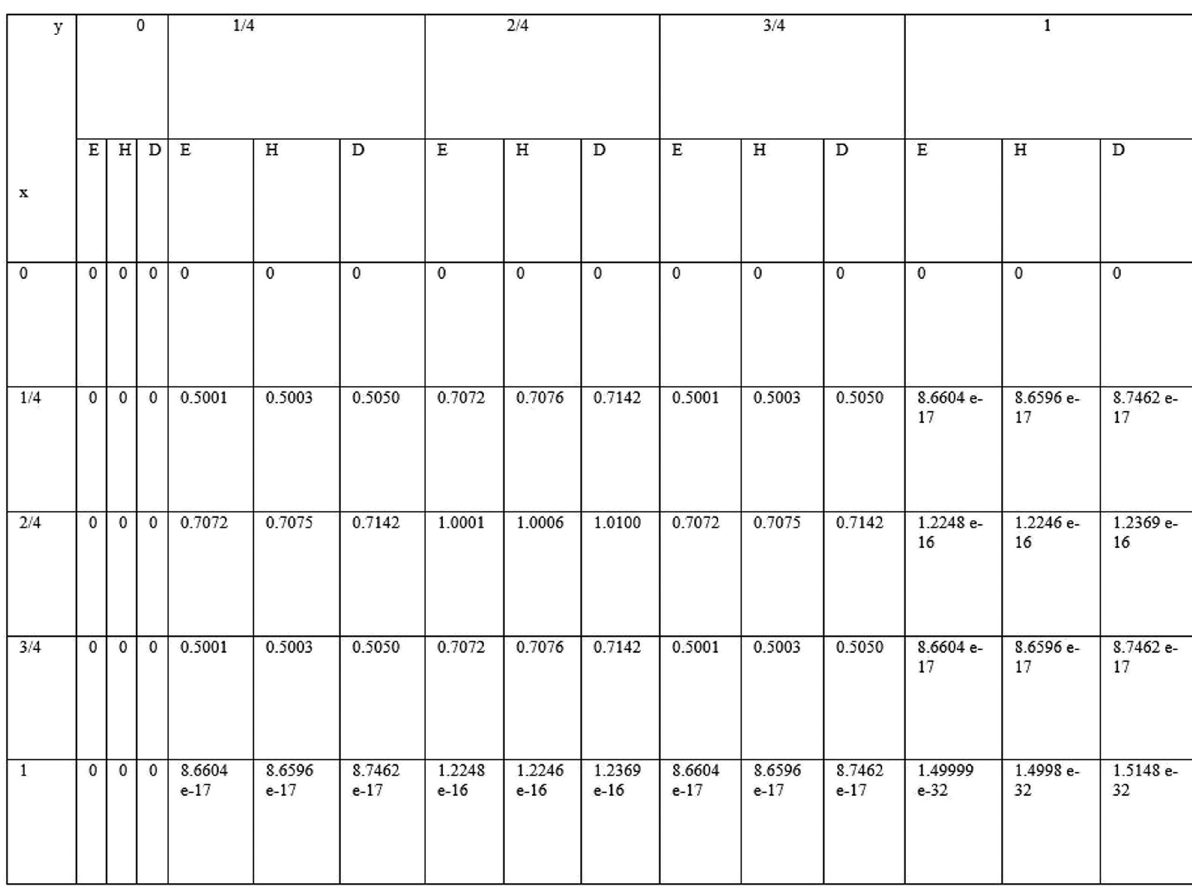
Figure 3: Comparison of exact and approximate solution of the di ff usion equation in Example 4.1 with ρ 0.4 = , T 0.01 = on a 5 5 ∗ mesh,